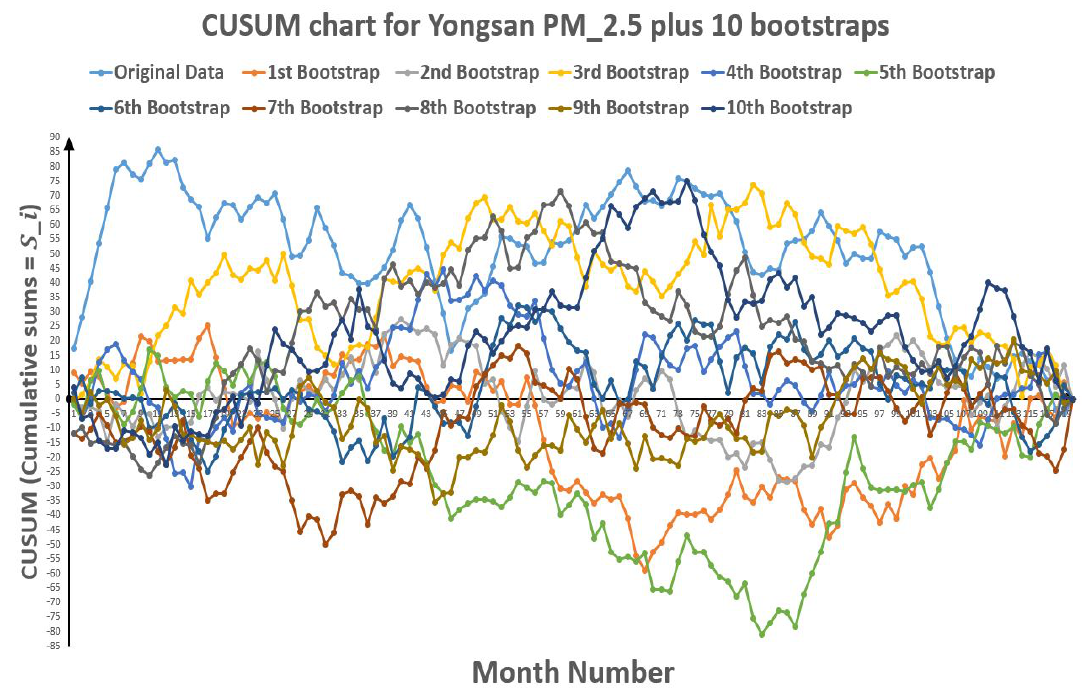
Figure 16. CUSUM chart for Yongsan PM 2.5 plus 10 bootstraps (European Standards).